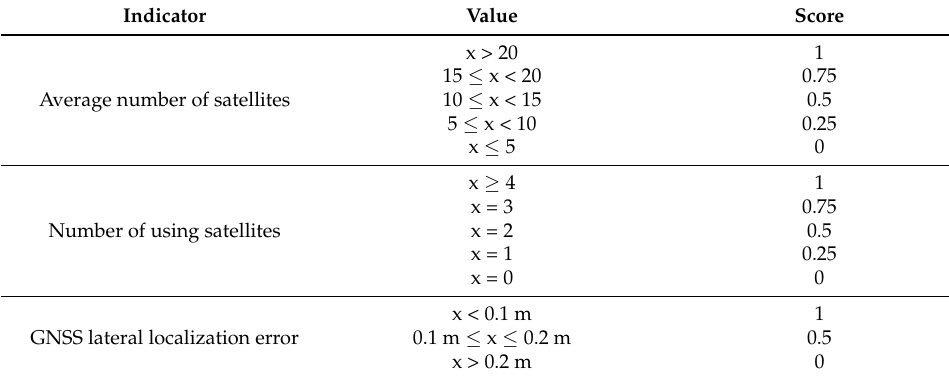
Table 2. The assessment framework—localization area.